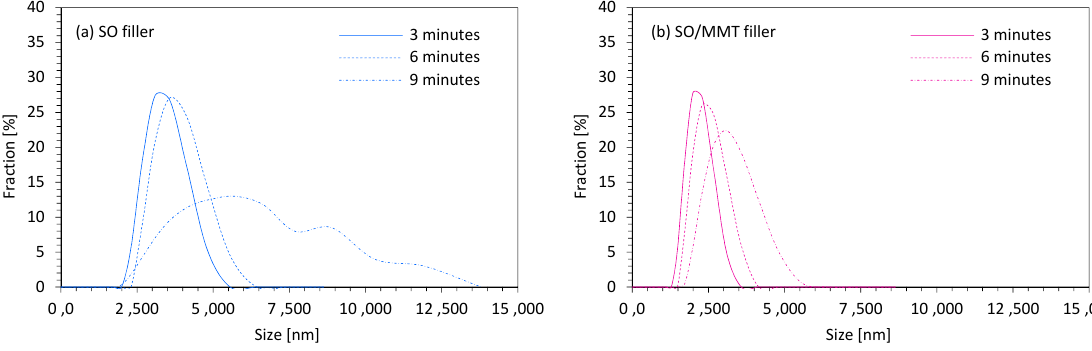
Figure 3. The particle size distribution of ( a ) SO filler, and ( b ) MMT-modified SO filler.